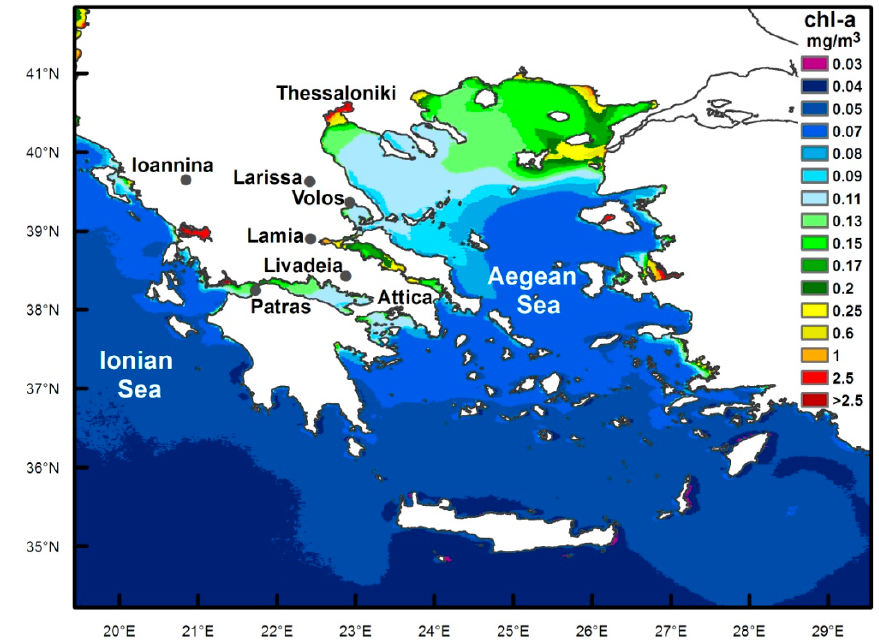
Figure 1. The main study area together with the chlorophyll concentration 1998–2016 climatological mean from June to September plus the geographical locations of PM10 stations.